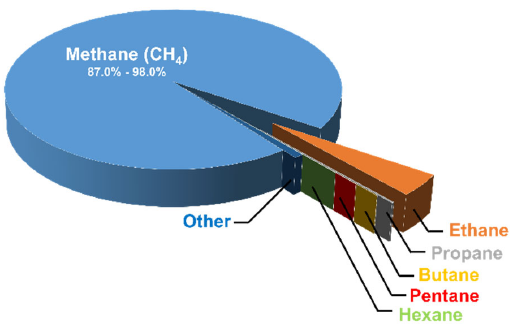
Figure 2. Composition of natural gas obtained from [7], which may vary depending on the extraction location (based on data from the website).